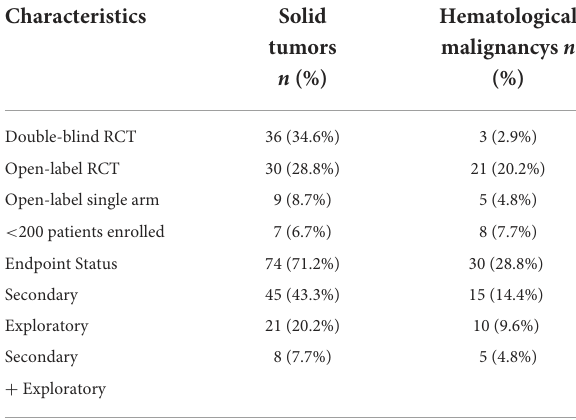
TABLE 2 Characterization of the studies that included patient-reported outcomes ( n = 104).